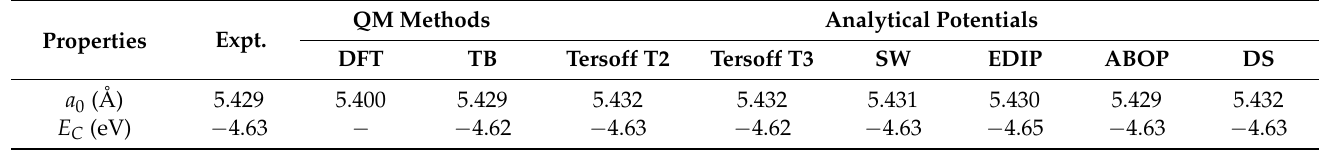
Table A1. Properties of silicon in its equilibrium structure [49] from experiment [50],